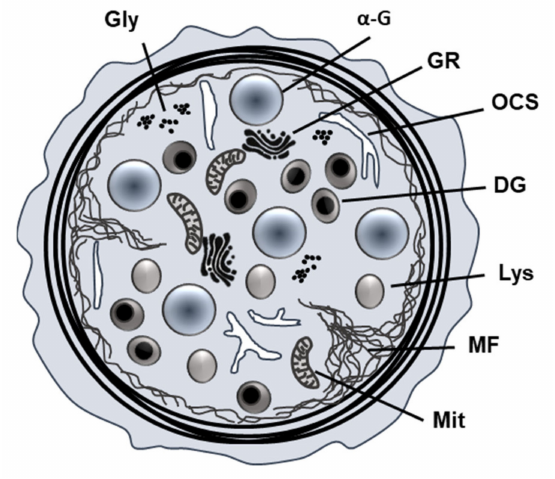
Figure 1. Schematic presentation of platelet granules. Platelets possess alpha-granules, dense granules and lysosomes. Abbreviations: Gly: glycogen, α -G: α -granules, DG: dense granules, Lys: lysosomes, GR: Golgi remnants, MF: microfilaments, Mit: Mitochondria, OCS: open canalicular system; Figure according to Neumüller et al., 2014 [20]. Table 1. List of platelet-derived factors. Factors are stored in dense bodies, lysosomes and α -granules. Factors stored in α -granules are distinguished by their function into regulators of growth and angiogenesis, coagulation factors, chemokines, adhesion molecules and immunologic molecules, according to Burnouf et al.